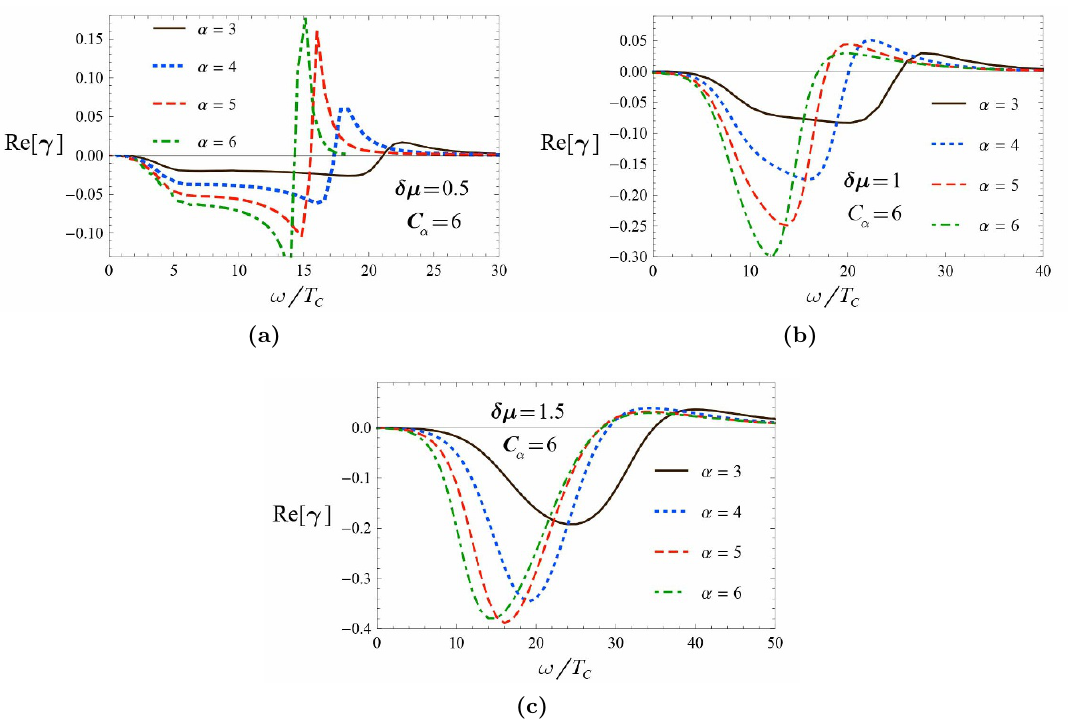
Figure 19. The real part of mixed conductivities in terms of !=T c for function F ( ) = 2 + C (cid:11) (cid:11) with (cid:11) = 3 ; 4 ; 5 ; 6 (solid curve, dotted curve, dashed curve, and dot-dashed curve), C (cid:11) = 6, and (cid:14)(cid:22) = 0 : 5 ; 1 ; 1 : 5 ((cid:12)gures (a), (b), and